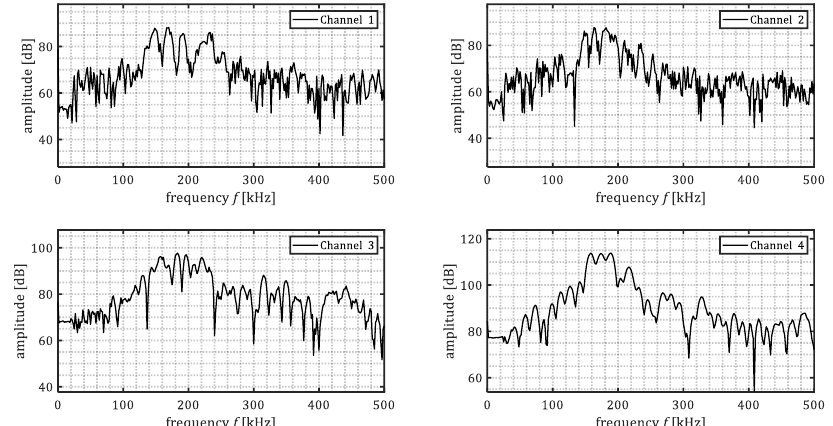
Figure 15. Samples of frequency content of one corrosion event (marine growth covered plate).